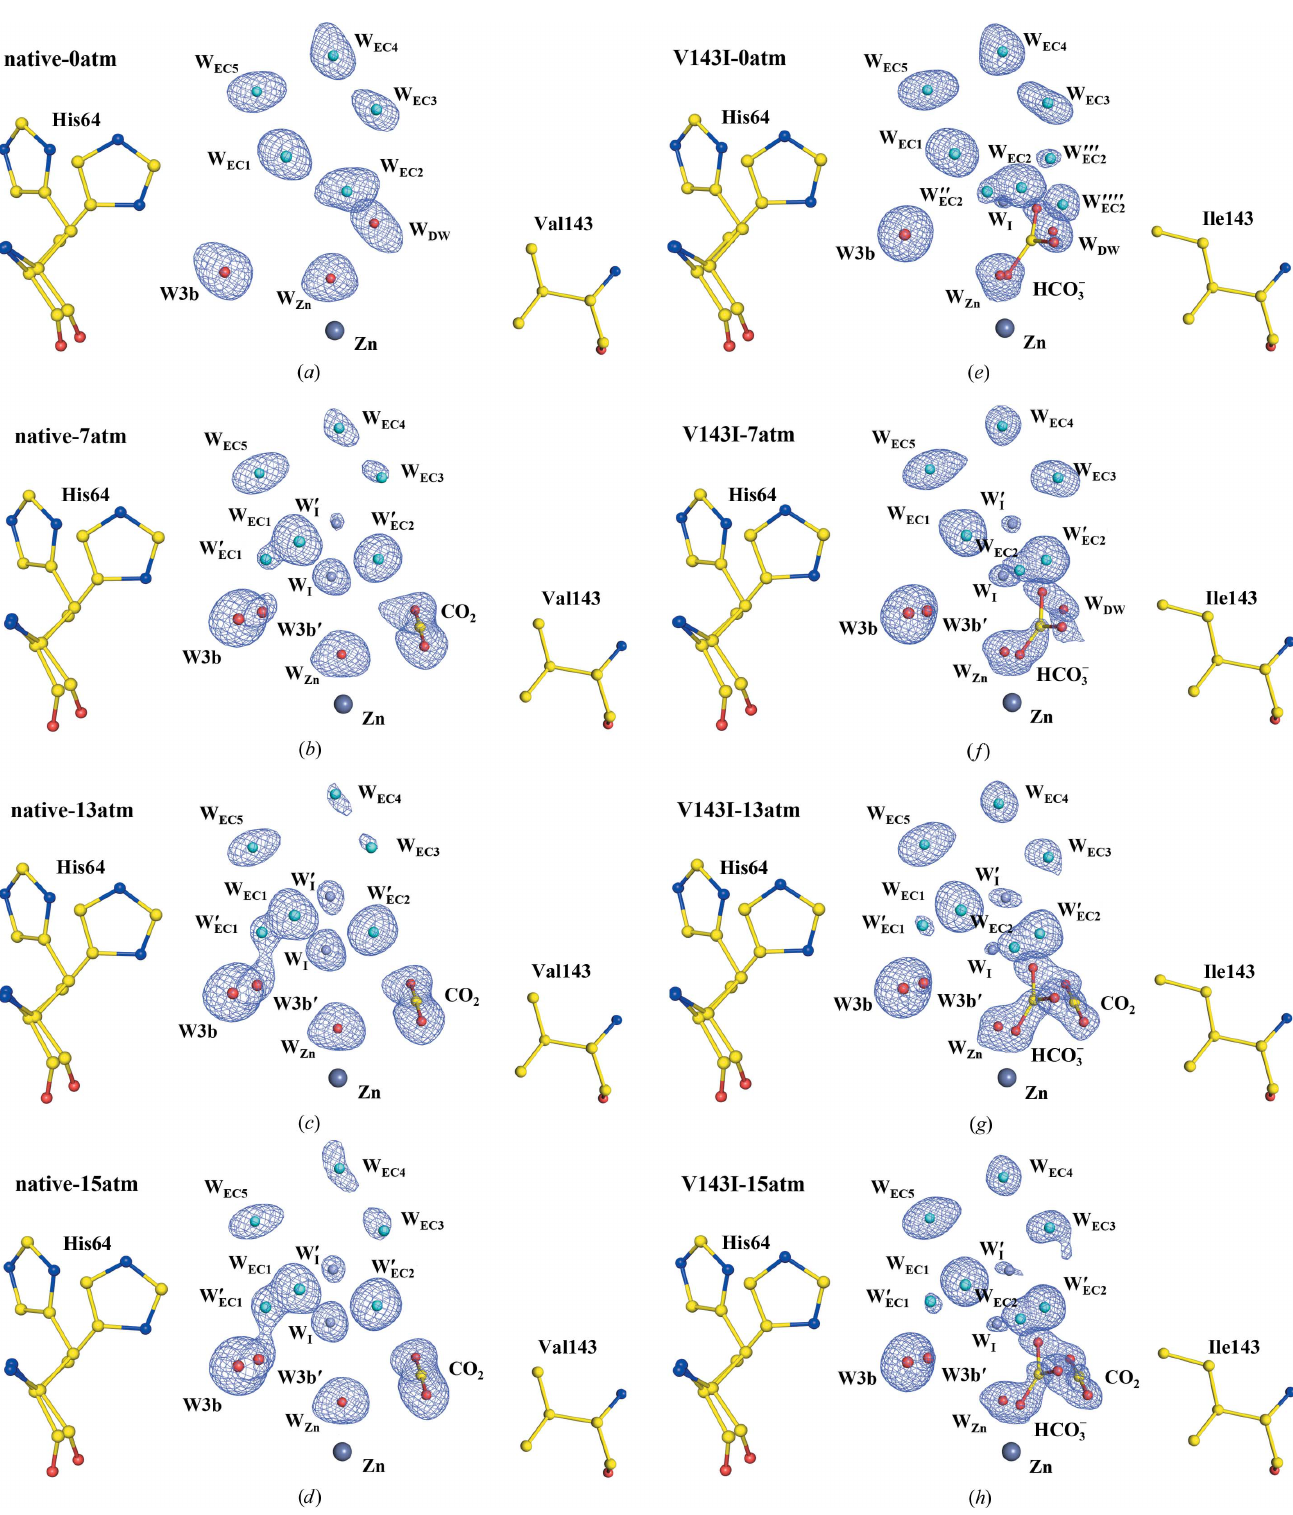
Figure 4 The water-replenishment pathway including entrance-conduit waters (cyan) and intermediate waters (steel blue). The electron density (2 F o (cid:2) F c ) is contoured at 1.5 (cid:2) where not indicated otherwise. ( a )–( d ) Native CA II structures. W EC3 at 7 and 13 atm and W EC4 at 15 atm are contoured at 1.25 (cid:2) , and W EC3 at 15 atm is contoured at 1.0 (cid:2) . ( e )–( h ) V143I CA II structures. W I 0 at 7, 13 and 15 atm and W 0 EC1 at 15 and 13 atm are contoured at 1.25 (cid:2) and W I at 0 atm is contoured at 1.0 (cid:2) . Compared with native CA II, V143I CA II shows significantly perturbed positions for W EC2